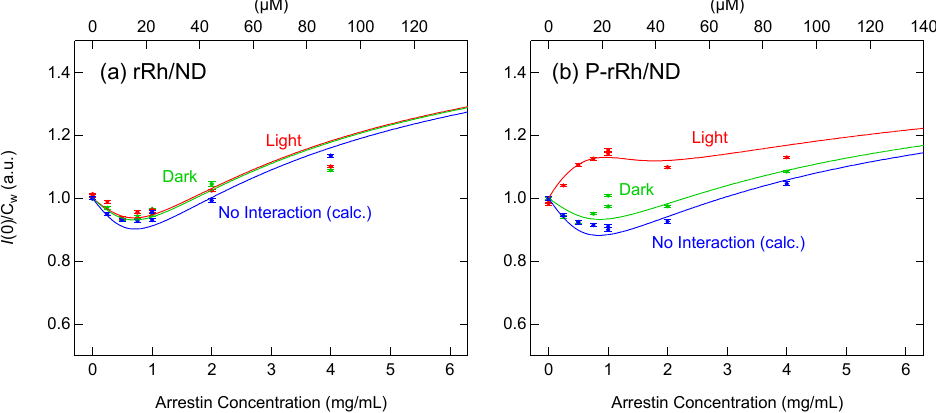
Figure 4. Light-induced formation of the complex of rhodopsin and arrestin. Various concentrations of arrestin were mixed with (a) rRh/ND or (b) P-rRh/ND (20–23 µM). I (0) before and after illumina- tion (Figure 3) was divided by the weight concentration of total proteins ( C W ) and plotted against the total arrestin concentration (green and red, respectively). For comparison, the sum of I (0)/ C W of arrestin and (a) rRh/ND or (b) P-rRh/ND separately measured is also plotted (blue). It was fitted using the equilibration model to estimate K complex (for details, see the text and Figure 5). To estimate I (0) in the absence of the interaction between arrestin and rRh or P-rRh, the scattering profiles of arrestin, rRh/ND, and P-rRh/ND were separately measured, and I (0) was estimated by the Guinier plot. The sum of I (0) of arrestin and rRh or P-rRh/ND